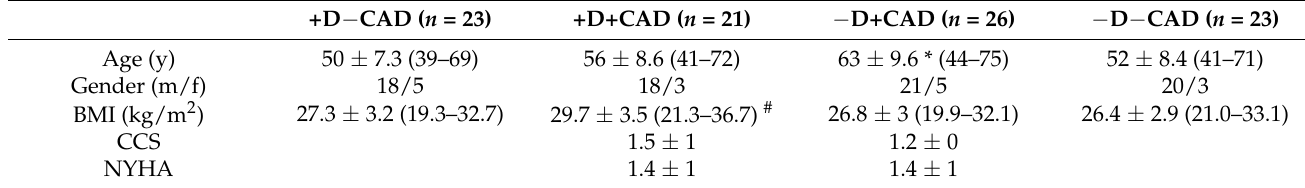
Table 2. Biological characteristics.